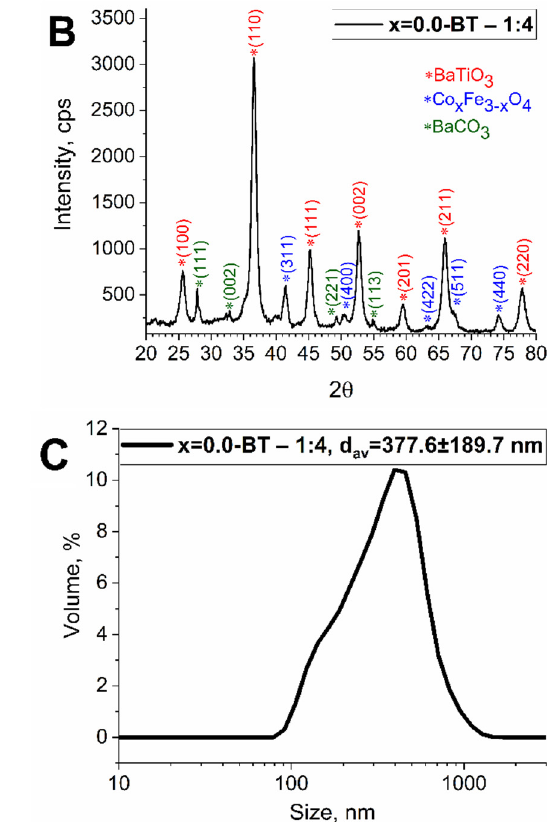
Figure 5. XRD ( A ) and EDX ( B ) study of the obtained x = 0.0-BT5%.